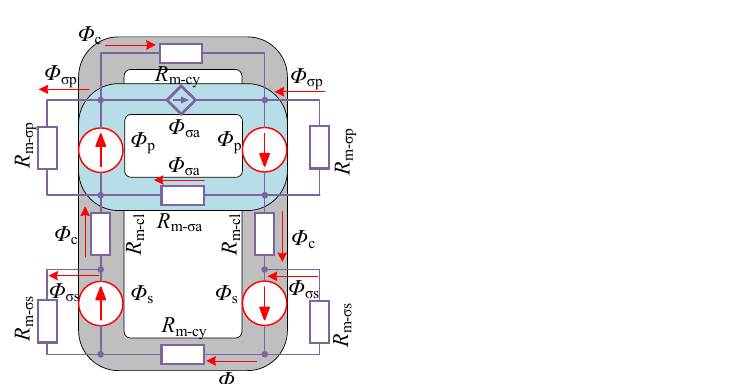
Figure 3. DAB circuit topology.